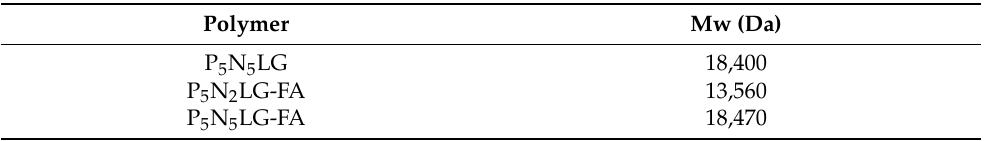
Table 1. Molecular weight of PNLG based polymers. Molecular weights of all the polymers are calculated based on the 1 H NMR